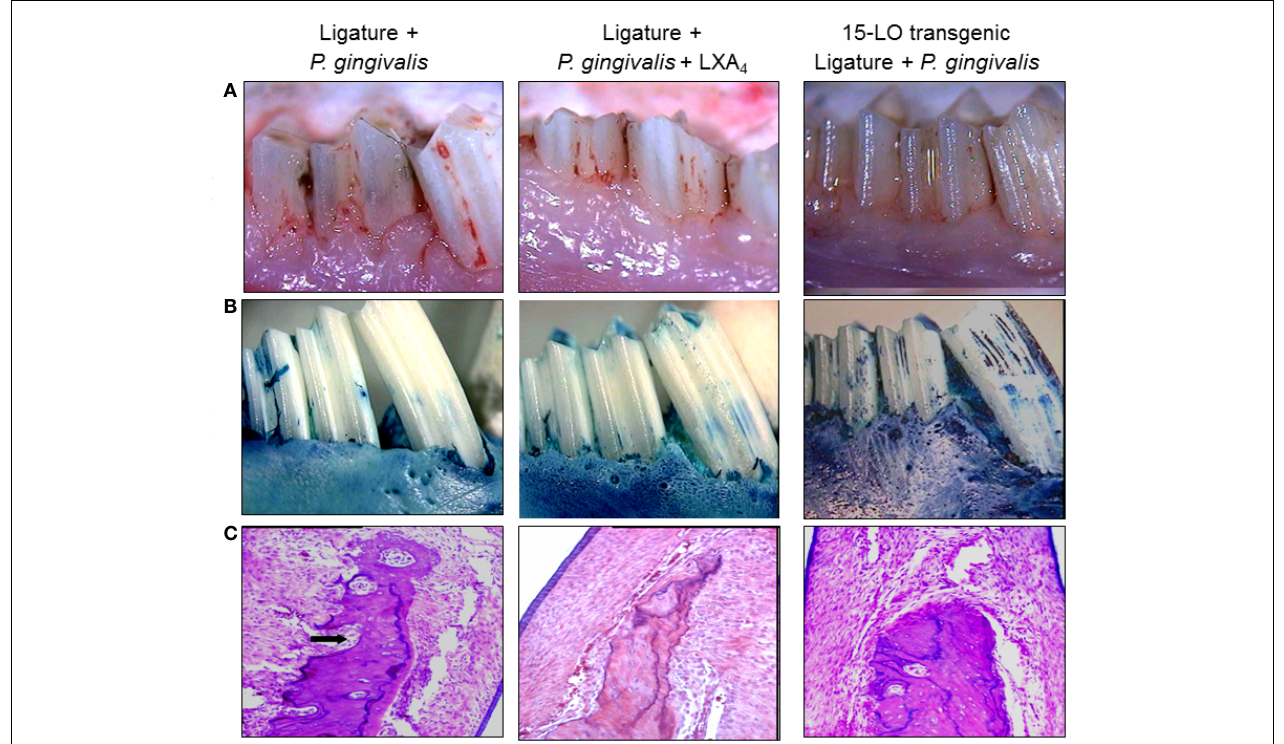
amount of bone loss as a result of the periodontal disease induced by the human oral microorganism, P. gingivalis (left panel). LXA 4 was capable of preventing from these inflammatory changes and bone loss (middle panel), while the 15 LO-TG rabbits were not affected by disease induction, and were completely resistant to the disease (right panel). (C) Histological evaluations have confirmed the clinical observations and once again showed a complete protection in 15 LO-TG rabbits from inflammatory changes demonstrated by an unaffected healthy bony architecture (right panel).Topical LXA 4 application protected from the destructive effects of periodontal disease as indicated by histological evaluations (middle